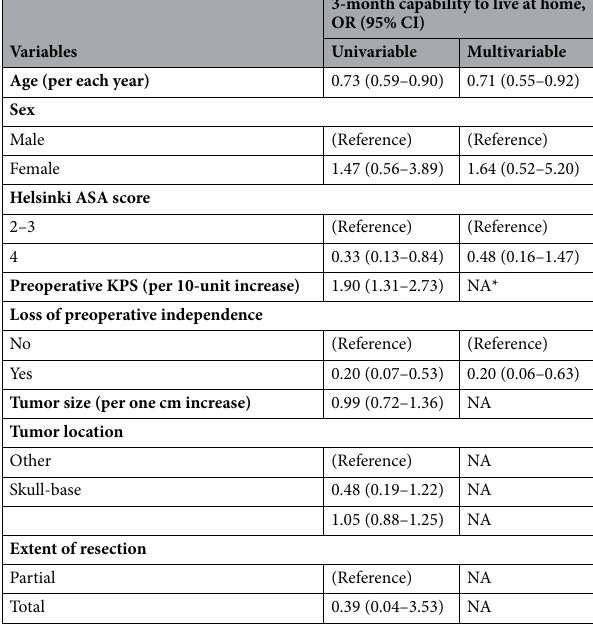
Table 3. Odds ratios (ORs) with 95% confidence intervals (95% CIs) for 3-month independence. Multivariable model includes significant factors from univariable model and patients’ sex. ASA American Society of Anesthesiologist; KPS Karnofsky Performance Status; NA not applicable. *Due to strong correlation between preoperative KPS and preoperative independence, we excluded preoperative KPS from multivariable